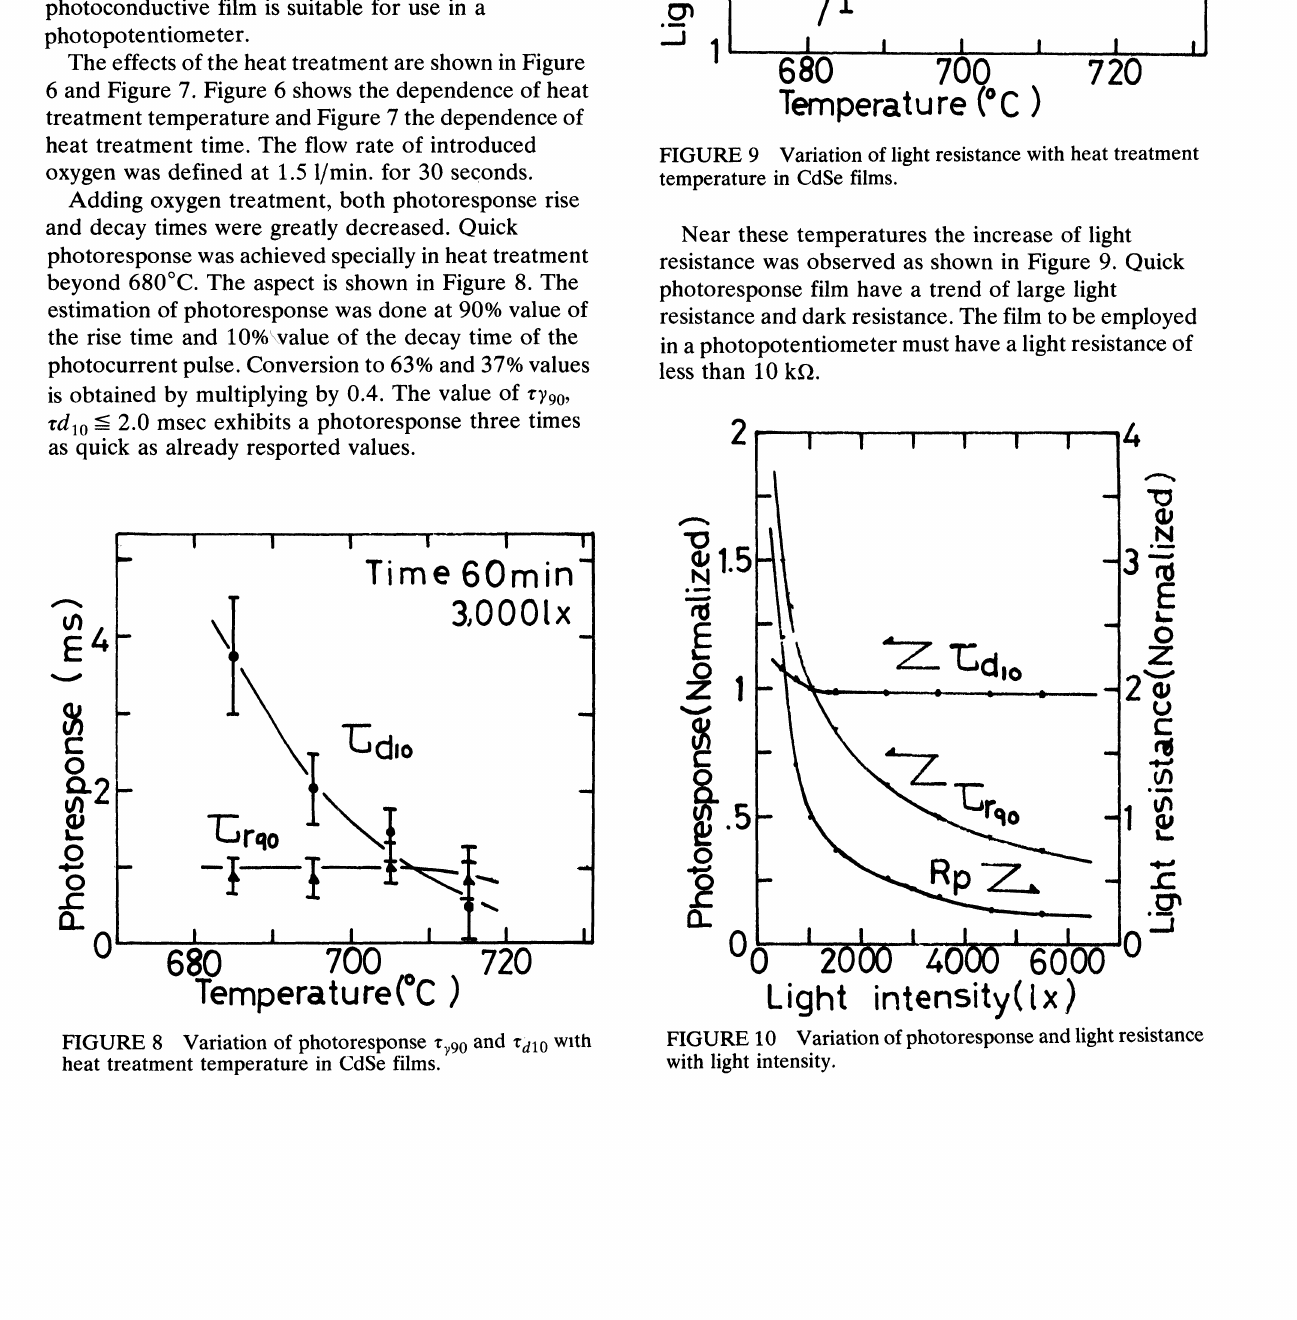
FIGURE 8 Variation of photoresponse 17r9 0 and lrdl 0 wth heat treatment temperature in CdSe films.